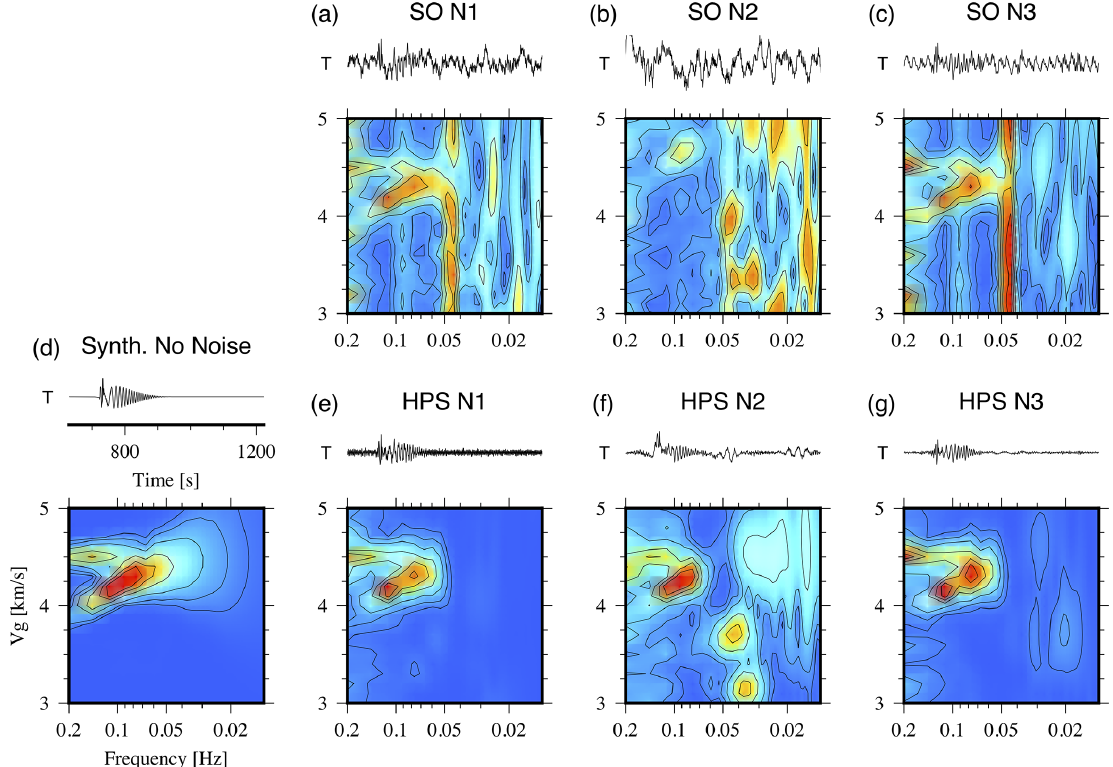
Figure 5. Love-wave group velocity analysis for unfiltered and HPS-processed synthetic Love wave trains contaminated by three real-world OBS noise signals (noise situations N1–N3, station D10, DOCTAR experiment, see Sect. 2 for more details). Lower panels in (a)–(c) : unfiltered synthetic signal (SO) MFT analysis results. Top panels: seismogram time windows corresponding to the range of group velocities shown on the y axis. (d) Noise-free synthetic case. (e)–(g) HPS-processed input traces for noise situations N1–N3 (lower panel: MFT analysis result, top panel: HPS processed